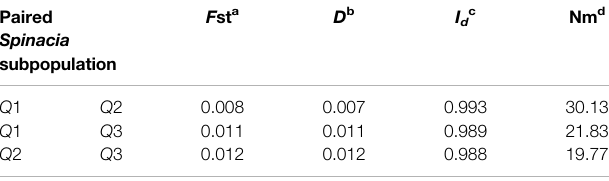
TABLE 2 | Population differentiation, genetic distance, genetic identity, and gene fl ow between pairs of three subpopulations of Spinacia oleracea and S. turkestanica identi fi ed using 7,065 single nucleotide polymorphisms (SNPs) common to 16 S. oleracea and 76 S. turkestanica accessions. Paired Spinacia